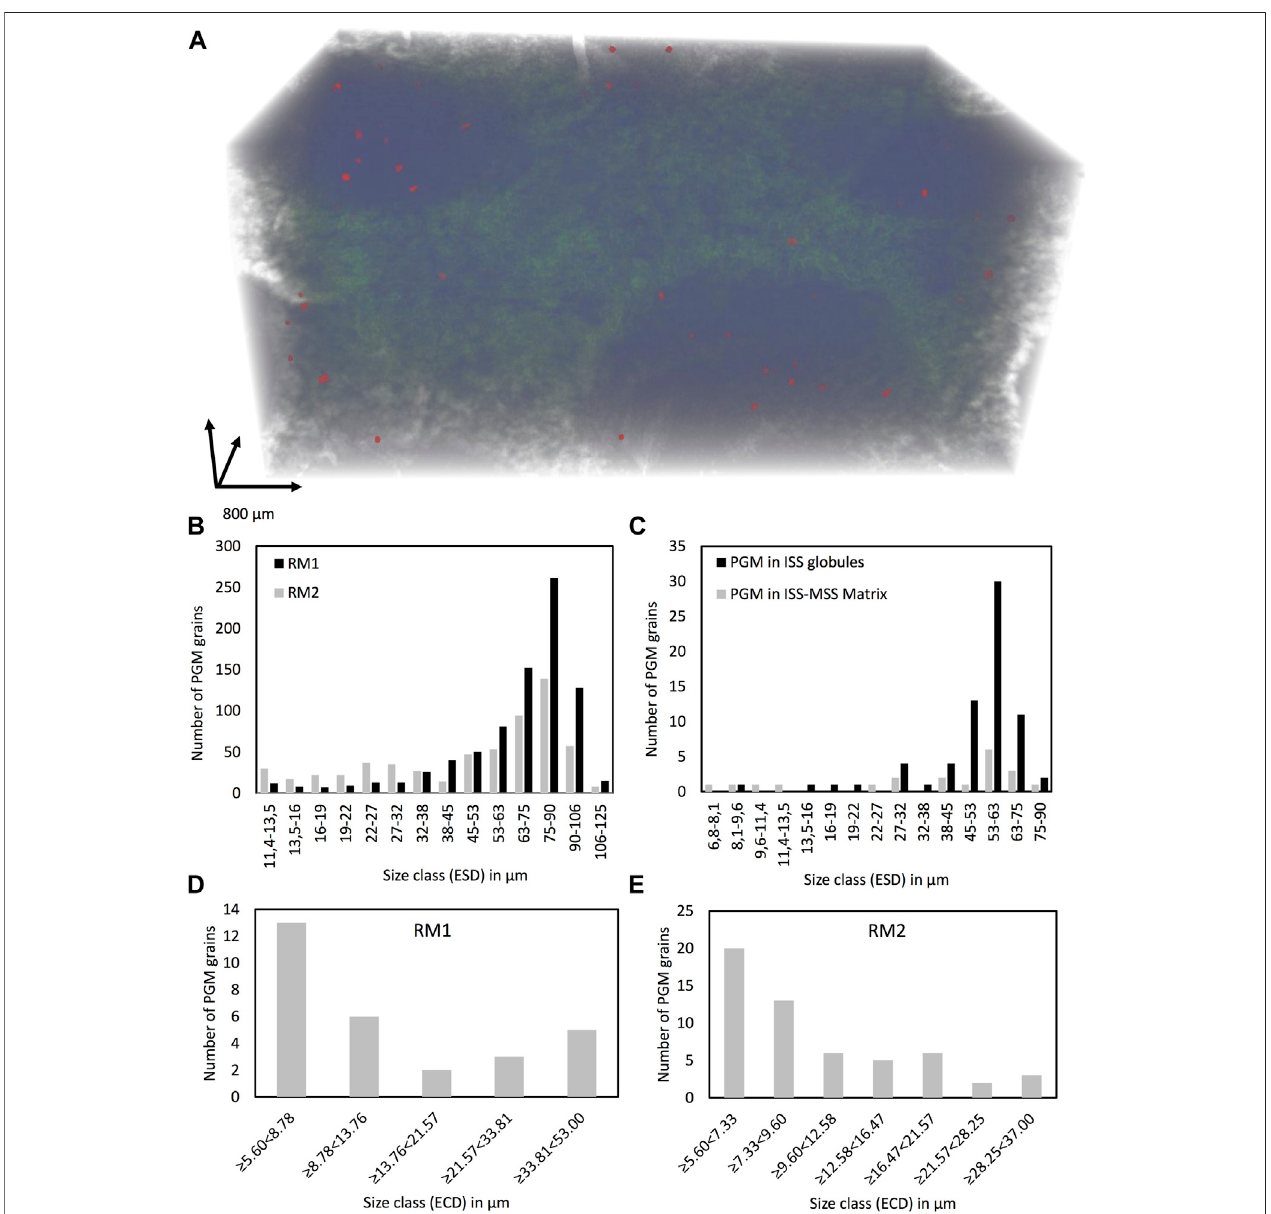
FIGURE 5 | (A) : Reconstructed 3D image of the sample RM1.29 VOI, with ISS (blue), MSS (green), and PGM (red); (B) : Size of PGM grains in different equivalent spherical diameter (ESD) classes in samples RM1 and RM2; (C) : Size of PGM grains in ISS globules and ISS-MSS matrix in sample RM1.29); (D) : Size of PGM grains in different equivalent circular diameter (ECD) classes based on SEM-EDS measurements of RM1; (E) : Size PGM grains based on SEM-EDS measurements of RM2.